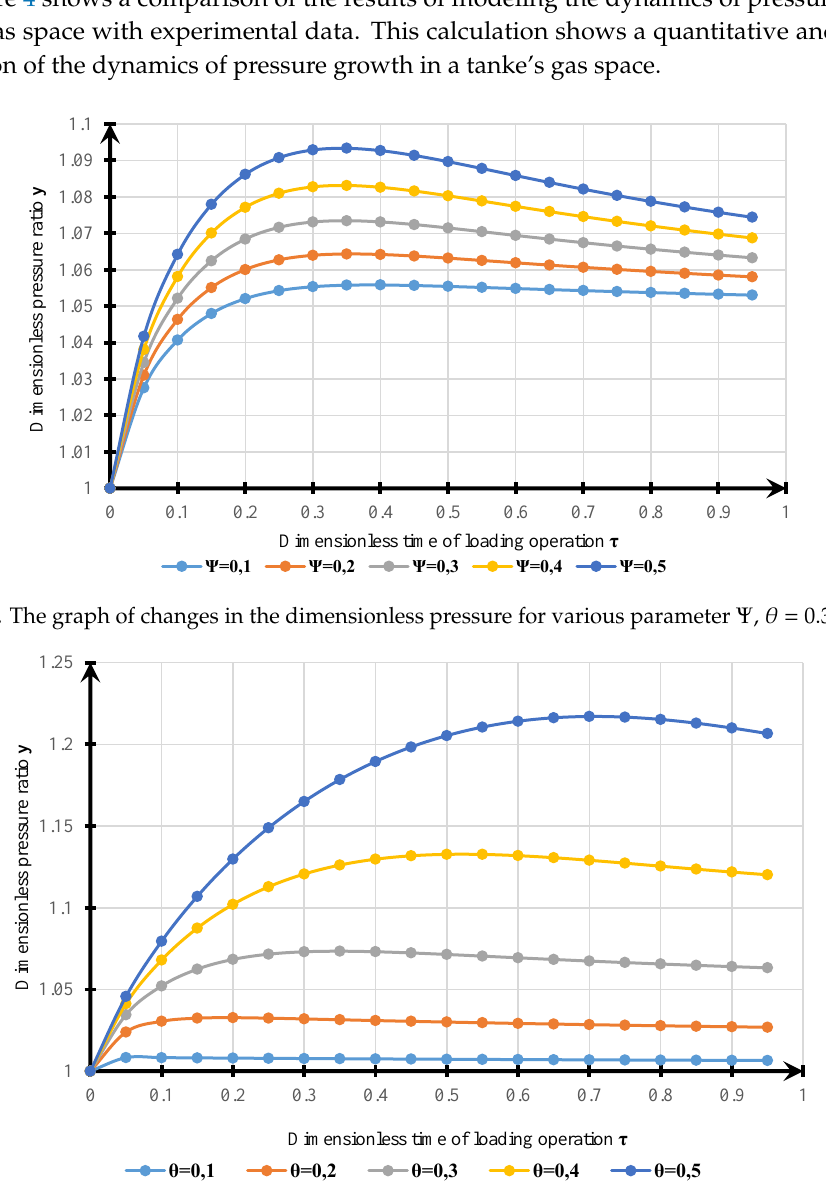
Figure 4. The graph of changes in the dimensionless pressure for various parameter θ , for ψ = 0.3 and ε = 0.8.